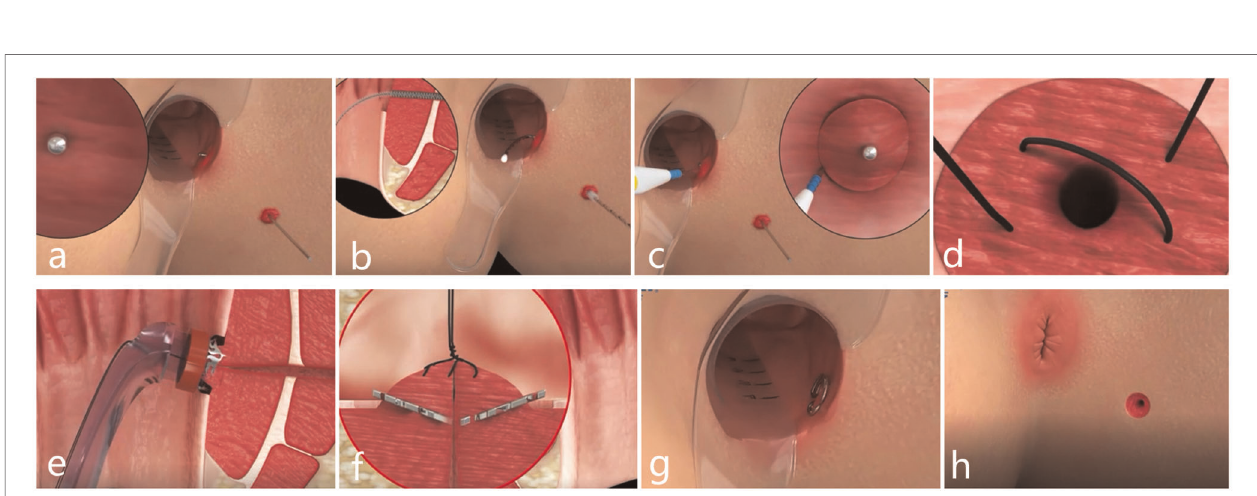
FIGURE 4 | Schematic diagram of the procedure for IOAC. ( A ) Curved metal probe was used to con fi rm the internal opening. ( B ) Epithelial tissue of the inner wall of the fi stula was cleaned by an anal brush. ( C ) Mucosa of 1 cm around the internal opening was removed. ( D ) Muscle layer was exposed and crossed sutured into a falling umbrella. ( E , G ) Internal opening was anastomosed by the anal fi stula clip. ( H ) External opening was enlarged for drainage.